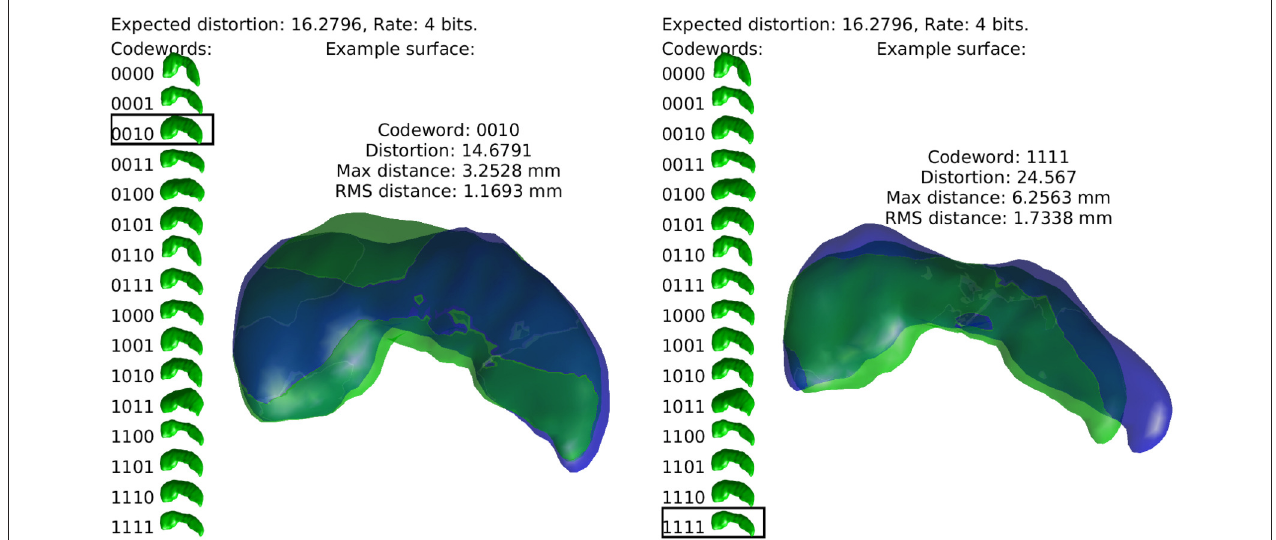
FIGURE 1 | The idea of the discrete coding is illustrated. Codewords, random realizations of anatomy, are shown at left in green. Two examples of real hippocampi are shown in blue, with their closest codewords overlayed in green.